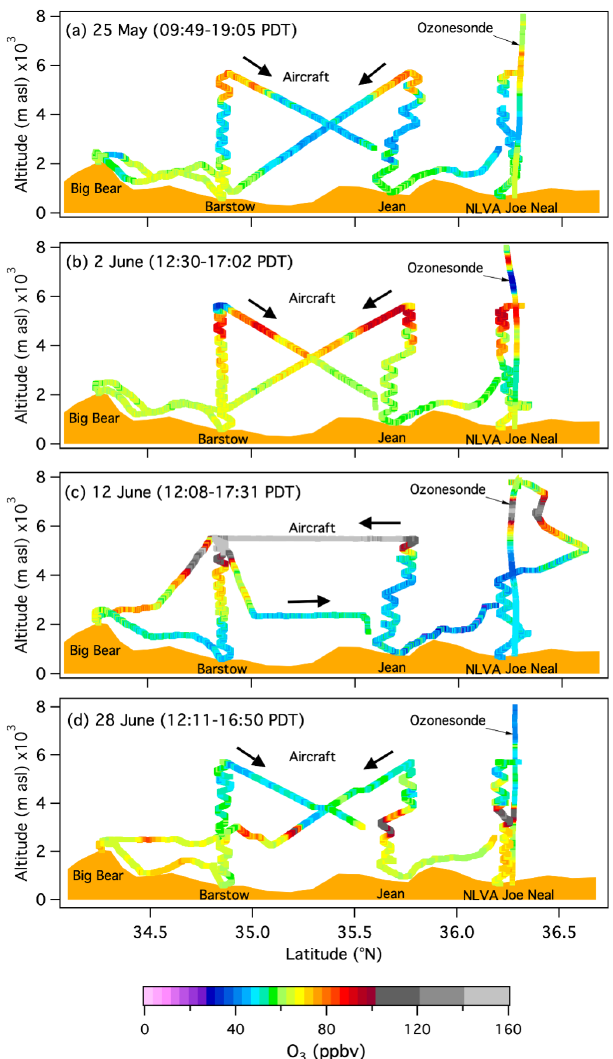
Figure 16. Ozone mixing ratios measured by the ozonesonde and aircraft on the flights to and from Big Bear on (a) 25 May, (b) 2 June, (c) 12 June, and (d) 28 June. The TOPAZ measurements and AP aircraft profiles are omitted for clarity, as are the Jean and NLVA aircraft profiles from the return legs. The terrain profile is approximate.